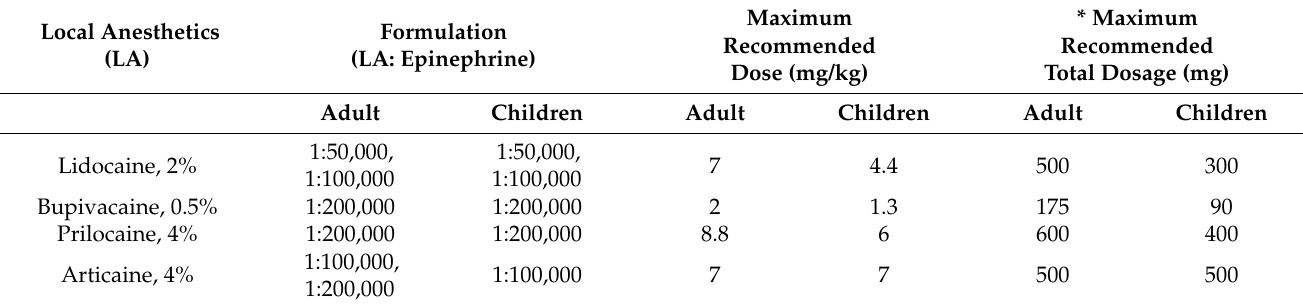
Table 5. Ratio of local anesthetics (LA) and epinephrine available in cartridges [2,4,5,71]. Local